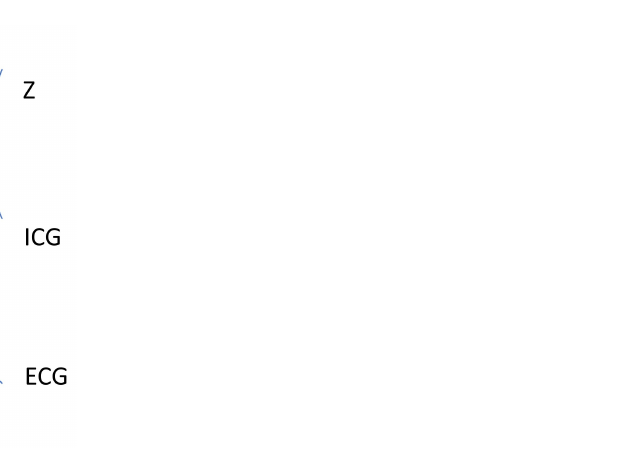
Figure 1. Typical patterns of the impedance Z, the resulting impedance cardiography (ICG) waveform (with the marked hemodynamic fiducial points B, C, X, Y, O, and A), and electrocardiography (ECG) waveform (with the waves P-QRS-T and relevant cardiac time intervals left ventricular ejection time (LVET) and pre-ejection time (PEP)) (from top to